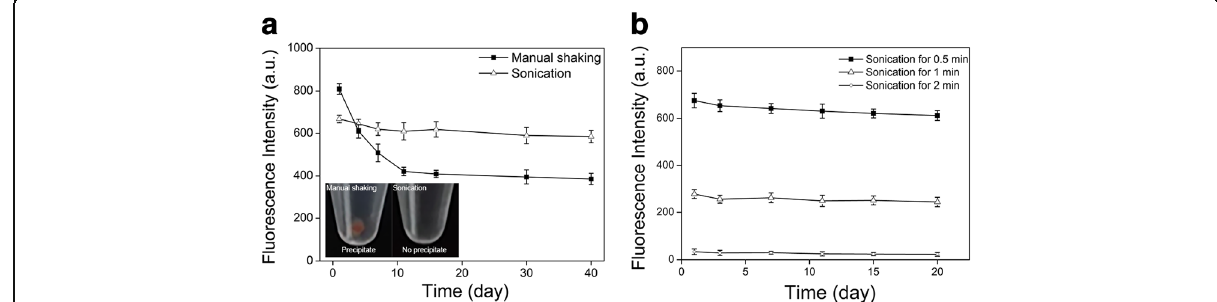
Fig. 2 Fluorescence stability of QD-encapsulated micelles fabricated by the interfacial instability process. a Change of fluorescence intensity (measured by fluorescent spectroscopy) over time for QD-encapsulated micelles, with the emulsion droplets formed by either manual shaking (for 1 min, i.e., ~25 μ m droplets) or sonication (for 30 s, i.e., ~3 μ m droplets), respectively. The insets are images of the QD-encapsulated micelle dispersions after 10 days of storage at 4 °C with the emulsion droplets formed by either manual shaking (for 1 min, i.e., ~25 μ m droplets) or sonication (for 30 s, i.e., ~3 μ m droplets), respectively. Panel a indicates that one cause of loss of fluorescence of QD-encapsulated micelles is the presence of colloidally unstable QD-encapsulated micelles. b Change of fluorescence intensity (measured by fluorescent spectroscopy) over time for QD-encapsulated micelles with the emulsion droplets formed by sonication (i.e., ~3 μ m droplets) for three different sonication treatment time durations. Panel b indicates that one cause of loss of fluorescence of QD-encapsulated micelles is QD surface defects generated by strong and prolonged mechanical